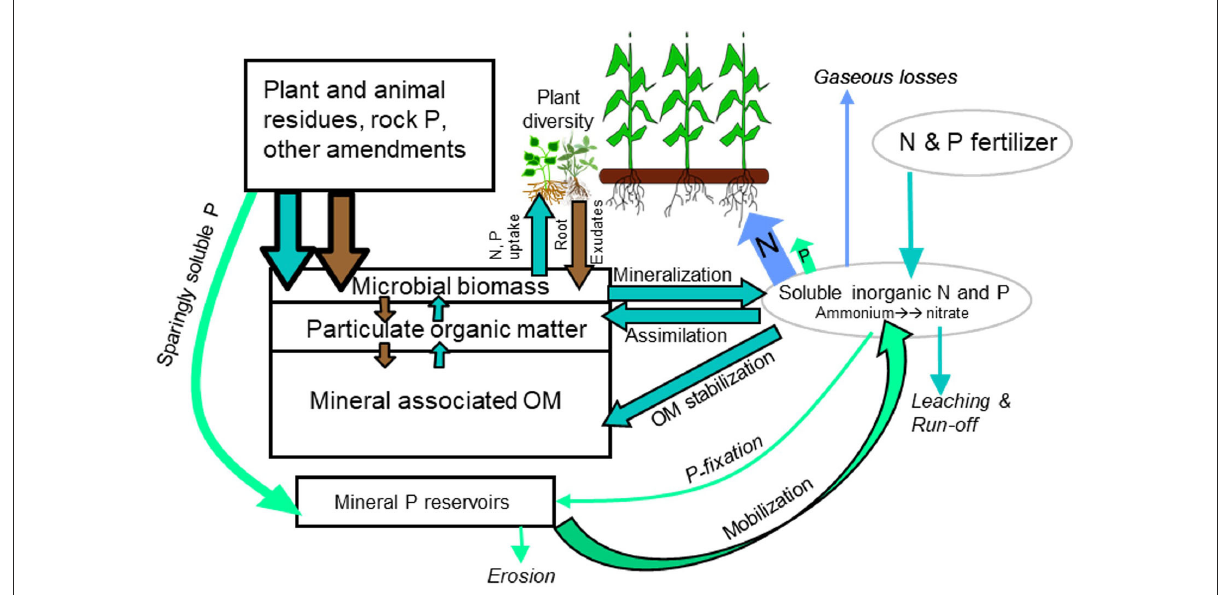
FIGURE1 ENM expands the focus of nutrient management to SOM pools and mineral P reserves. Flows, inputs, and pools that are increased under ENM are outlined in black. Arrow colors indicate dominant elemental fluxes as follows: N only (blue), P only (green), N and P (blue green), and C (brown). Modified after Drinkwater and Snapp,